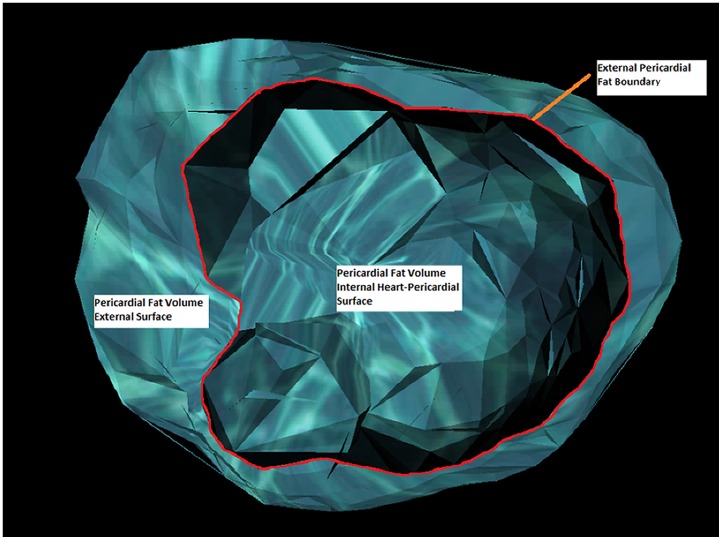
Pericardial fat (PF) volume, cranio-caudal view of internal and external surface of its tridimensional reconstruction.Exclusion of the most cranial axial surface to display the internal cavity of PF volume.